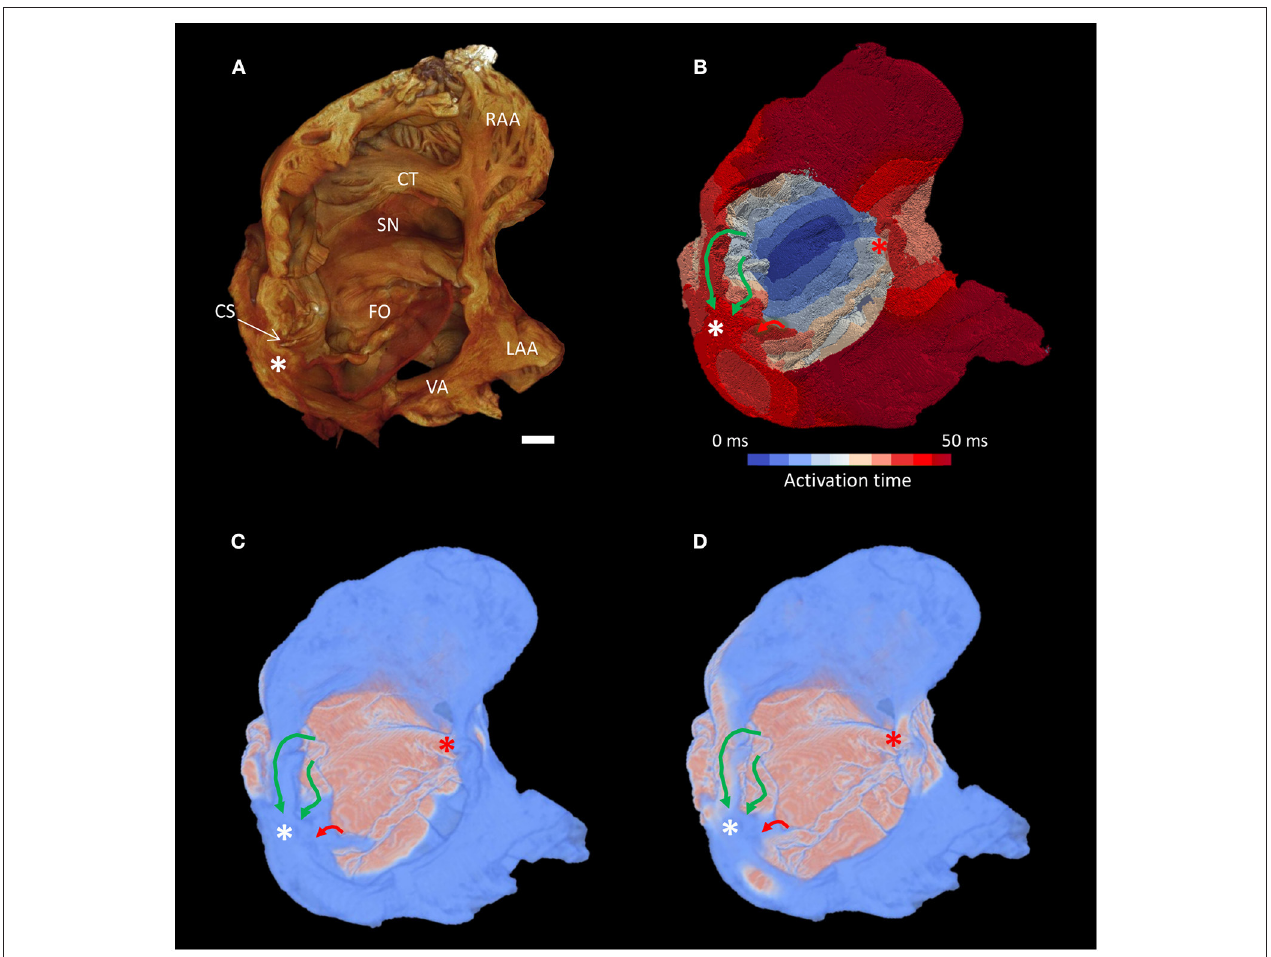
FIGURE 7 | Preferential inter-nodal conduction via the “slow” pathway in the atria of a heart with AVSD. (A) Volume rendering of the atrial cavity viewed from the inferior-lateral position. (B) Corresponding isochrone electrical activation map, the normal location and direction of the “slow” pathway (green), and the septal aspect of the elongated “fast” pathway (red) are indicated by solid arrows. (C,D) Snapshots taken from the Supplementary Video 2 showing excitation of the distal aspect of the region normally associated with the “slow” pathway precedes that of the “fast” pathway, pink indicates activated myocardium, light blue indicates dormant myocardium. See methods for modeling parameters. White*, location of compact atrioventricular node in AVSD heart; Red*, approximate location of compact atrioventricular node in normal heart; CS, coronary sinus; CT, terminal crest; FO, fossa ovale; LAA, left atrial appendage; RAA, right atrial appendage; SN, sinus node; VA, valve annulus. Scale bar represents